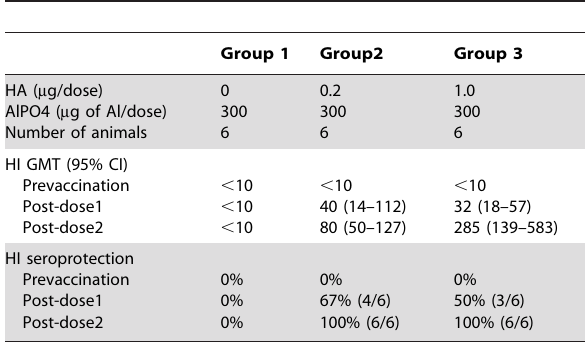
Table 2. Immunogenicity of inactivated influenza H5N1 vaccine candidates in